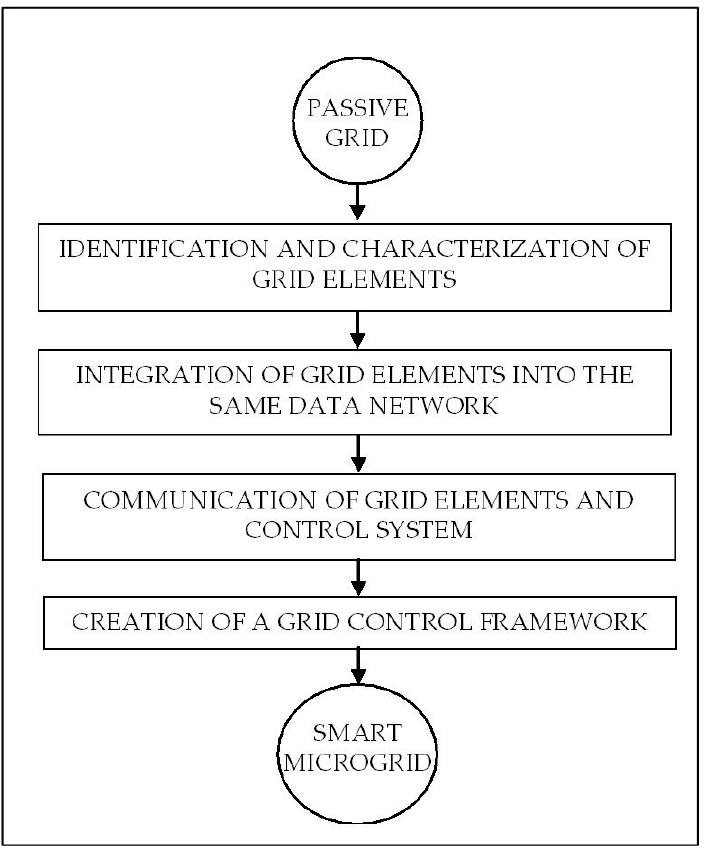
Figure 1. Stages of the procedure to transform passive grid into a smart microgrid. Source: prepared by authors.